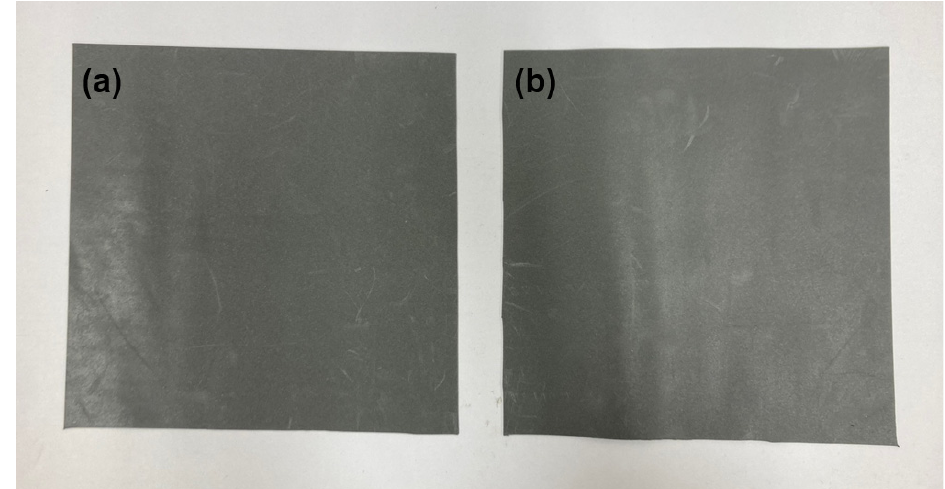
Figure 2. Appearance of shielding films based on ( a ) Emulsion polymer; ( b ) Powder polymer.